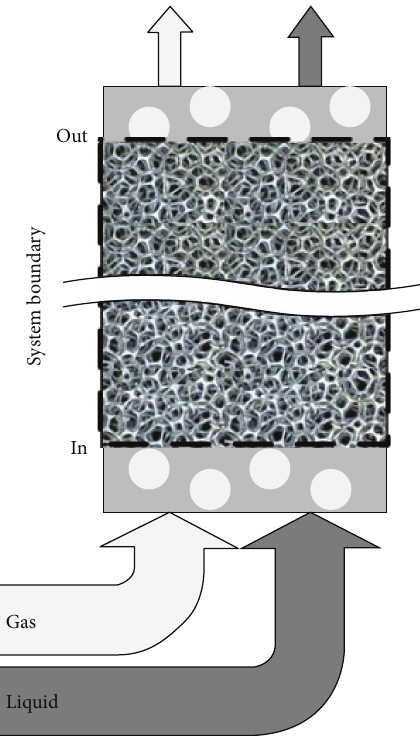
Figure 2: System boundary for the mathematical model